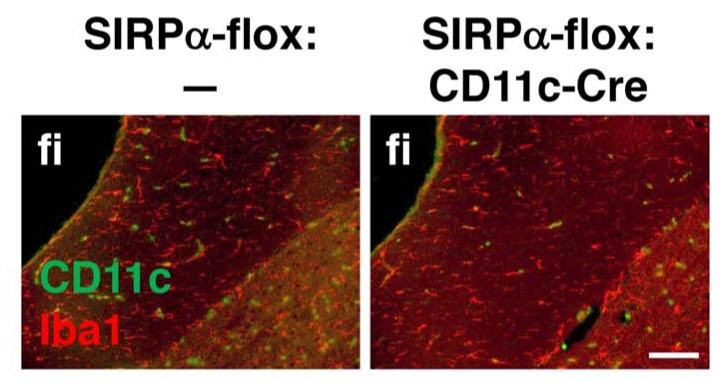
Immunohistochemical analysis of CD11c+ cell-specific SIRPα cKO mice.Brain sections prepared from control (SIRPα-flox:—) and CD11c+ cell-specific SIRPα cKO (SIRPα-flox:CD11c-Cre) mice at 25 wks of age were immunostained with antibodies to Iba1 (red) and CD11c (green). Merged images are shown. fi, fimbria. Data are representative of at least three independent animals. Scale bar: 100 μm.